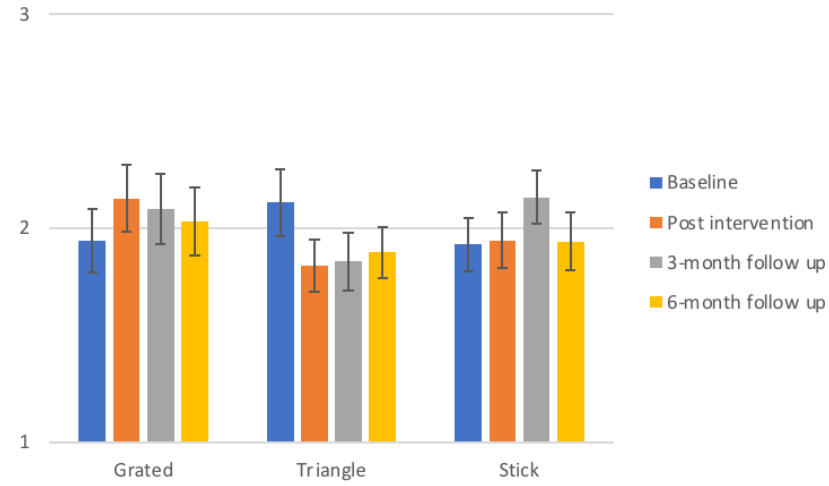
Figure 6. Ranking scores ± SEM for the different shapes of beetroot throughout the control sessions.